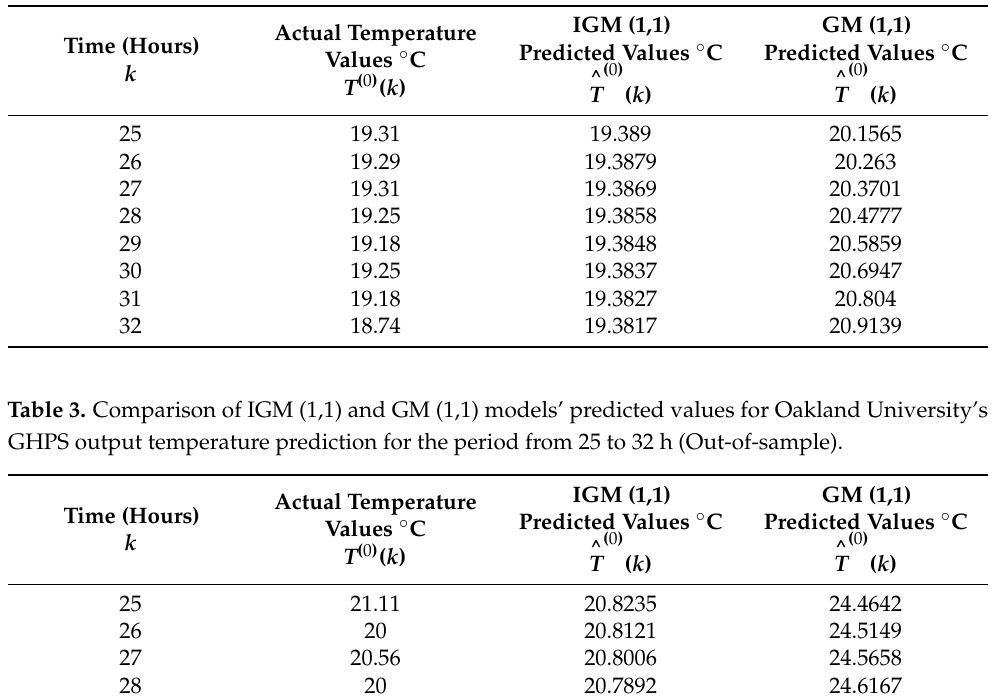
Table 2. Comparison of IGM (1,1) and GM (1,1) models predicted values of the Polit è cnica de Val è ncia